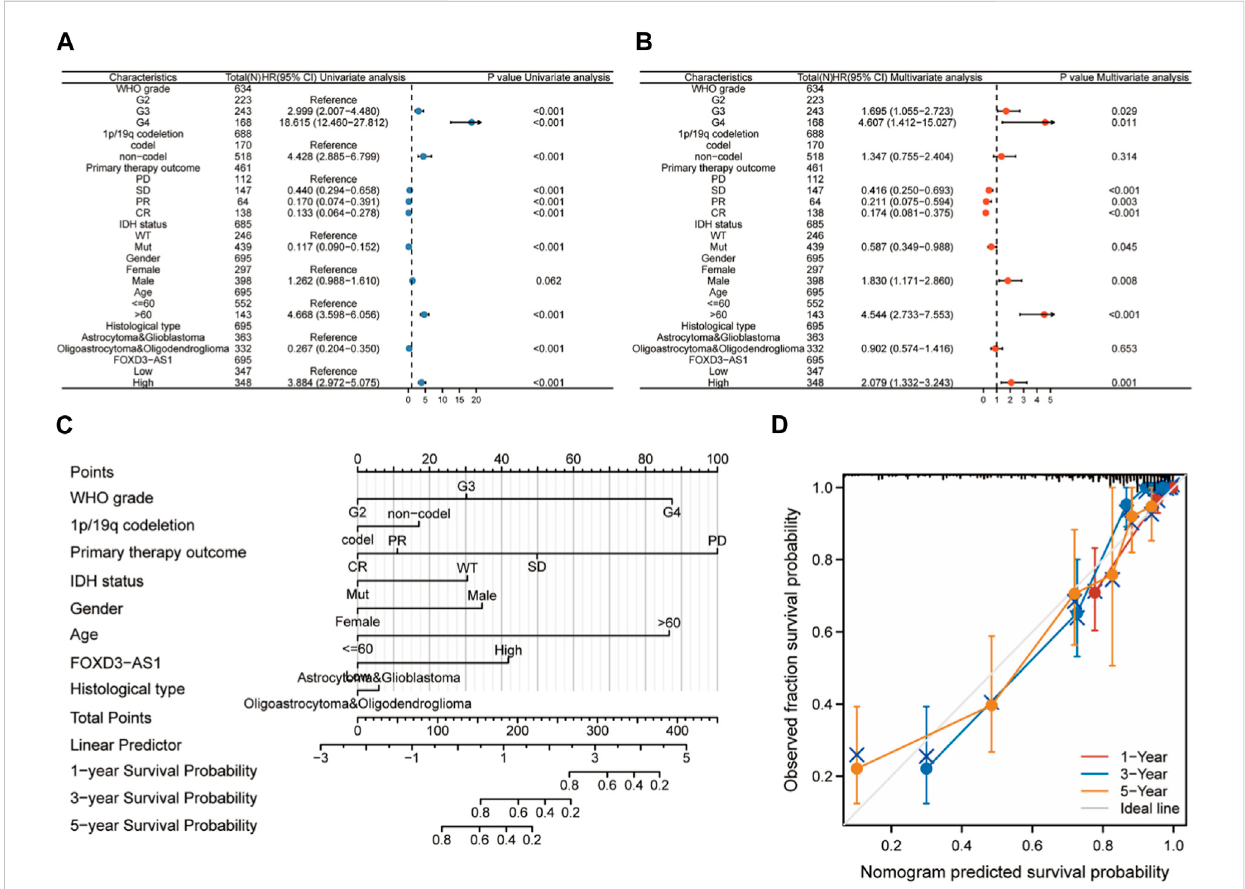
FIGURE 6 Cox regression analysis and nomogram construction based on FOXD3-AS1. (A, B) Univariate and multivariate Cox regression analysis based on FOXD3-AS1lcombinedwithclinicopathologicalfactors; (C,D) Prognosticnomogramandcalibrationcurveofcomprehensiveclinicopathologicalfactors in FOXD3-AS1 combined with GBM and LGG